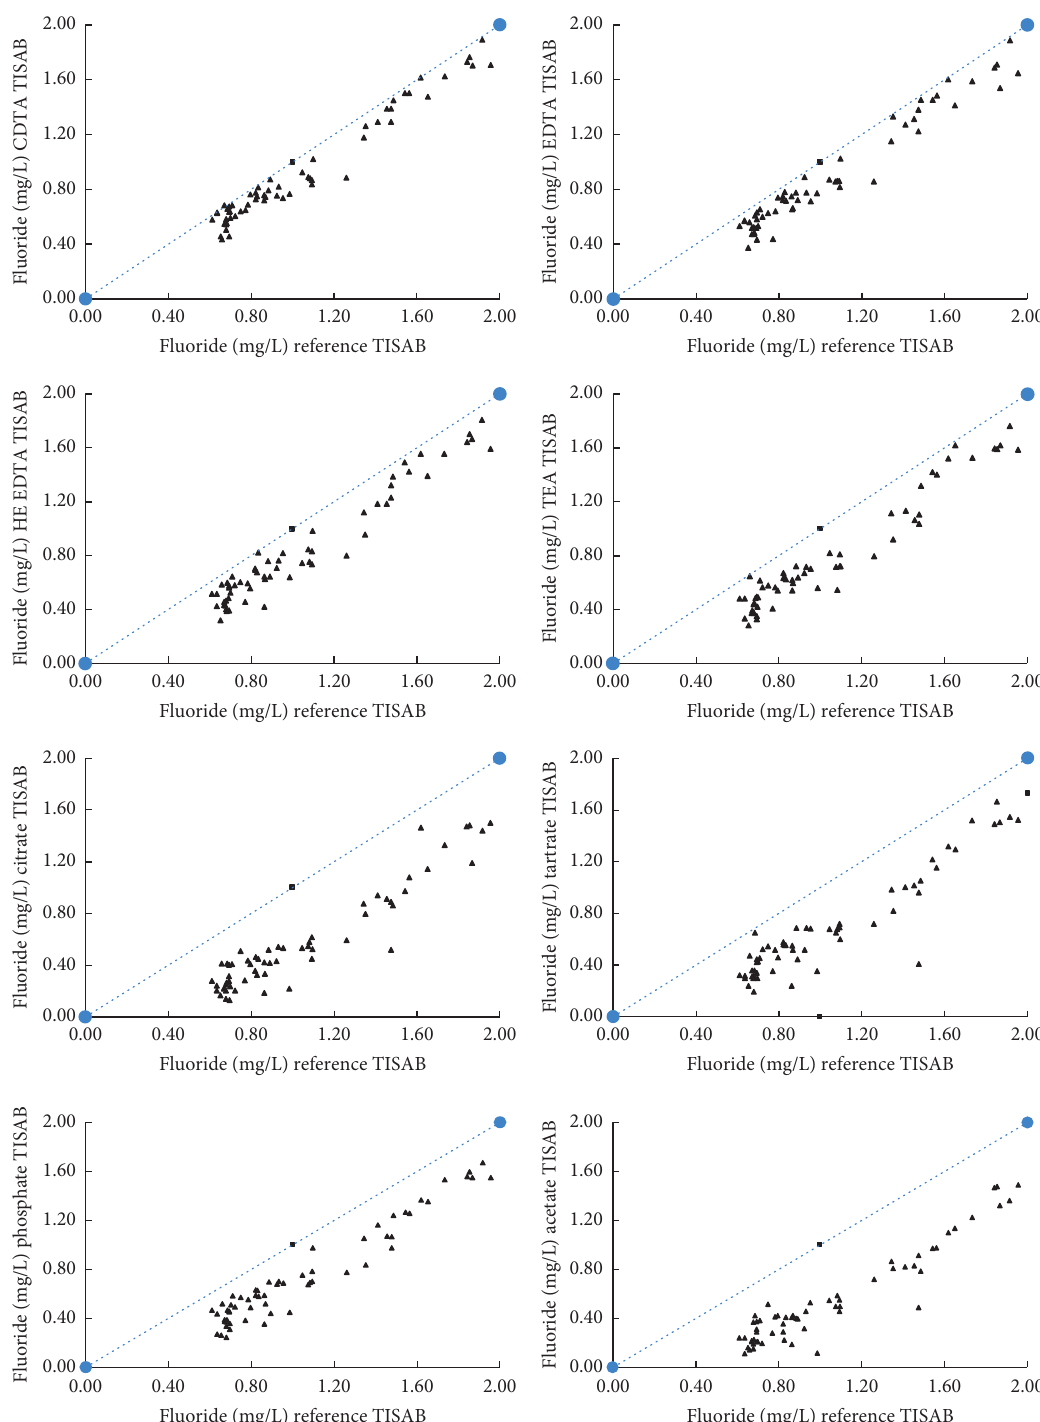
Figure 1: Graphical representation of the fluoride concentrations determined by the lab prepared TISAB solutions with respect to reference buffer